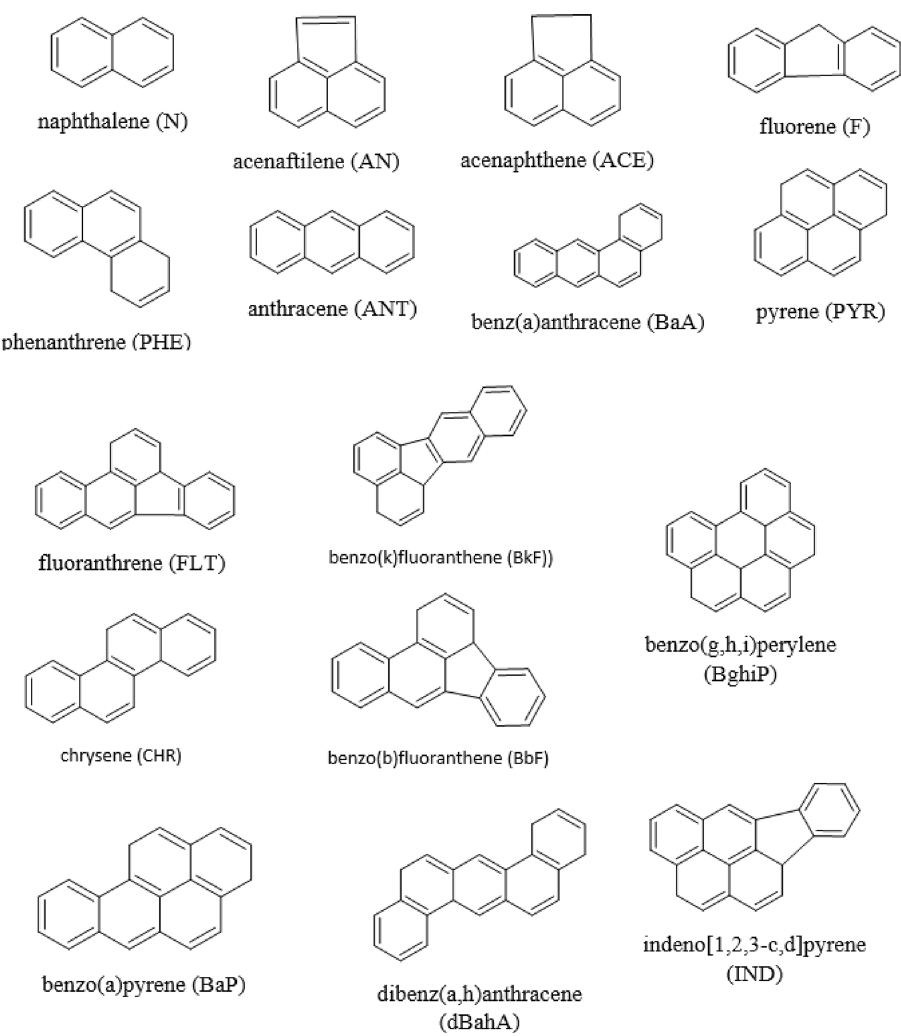
Figure 1. Structural formulas of priority